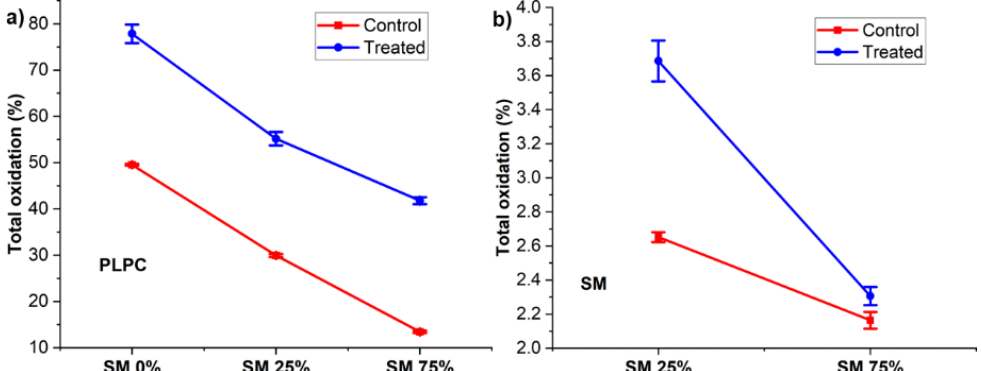
Figure 5. Total oxidation of PLPC ( a ) and SM ( b ) after 30 min plasma treatment of lipid bilayers with different SM fraction (indicated “Treated”) and without treatment (indicated “Control”) ( n = 3). Total oxidation is defined as the sum of lipid peroxidation product (LPP) peak areas quantified in each sample relative to the peak area of non-oxidized parent lipid. Note that the different graphs have different scaling of the y -axis.